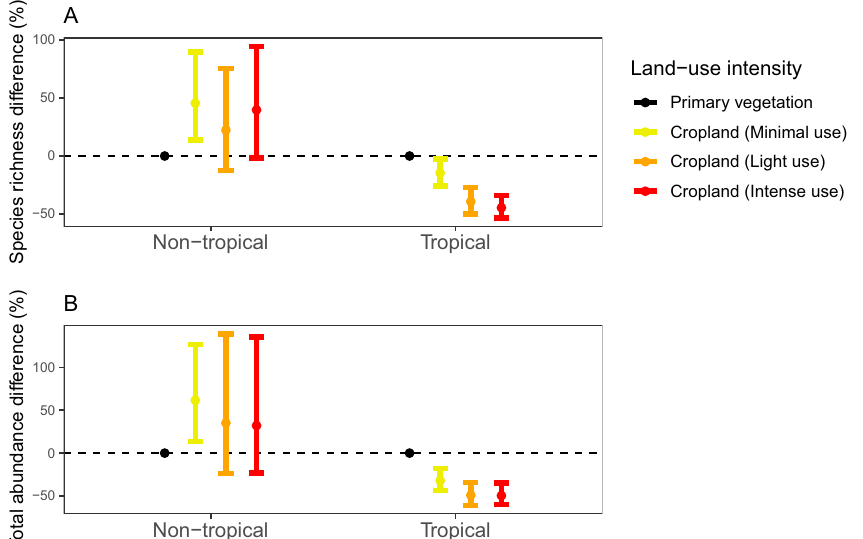
Fig. 3 Response of pollinators to land-use intensity on cropland, for non-tropical and tropical sites. Each panel represents a linear or generalised linear mixed-effects model for a given biodiversity metric: A species richness; and B total abundance. We excluded Simpson diversity here since AIC was greater for the main model than the intercept-only model. Colours represent the land-use intensity level, with primary vegetation (minimal use) as the reference factor: black (primary vegetation, minimal use); yellow (cropland, minimal use), orange (cropland, light use), and red (cropland, intense use). Effect sizes were adjusted to a percentage by sampling fi xed effects 1000 times based on the variance-covariance matrix, expressing each fi xed effect as a percentage of the value in primary vegetation for that geographical zone, and then calculating the median value (shown as points), and 2.5th and 97.5th percentiles (shown as error bars). See Supplementary Table 8 for the number of sites and Supplementary Tables 9 and 10 for the model summaries. Source data are provided as a Source Data fi le.